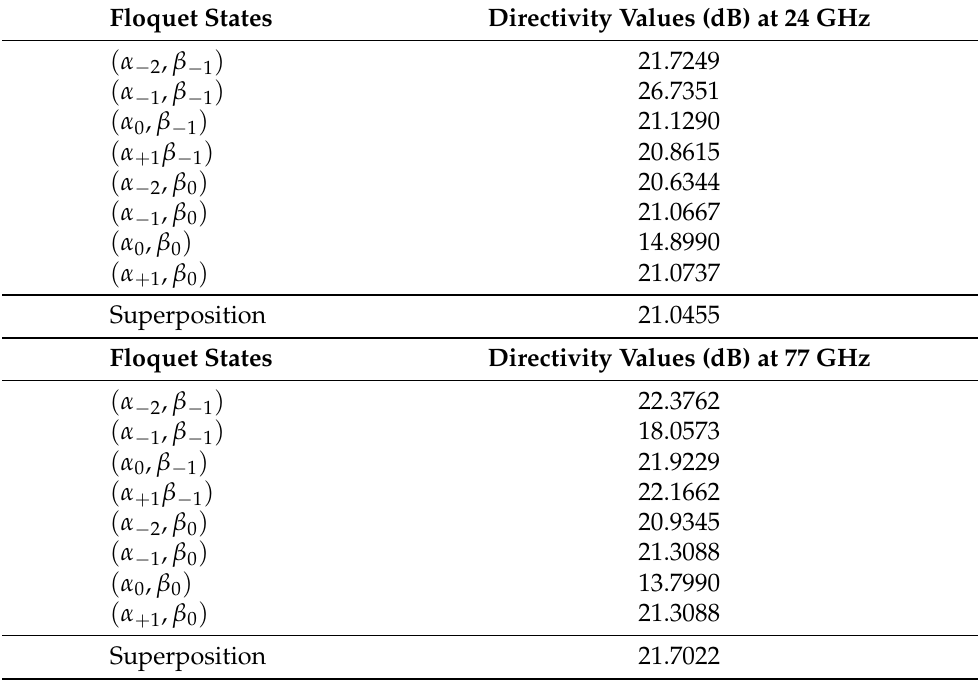
Table 2. Directivity versus Floquet states and the superposition theorem (or the modulation as explained in Formula (13), which transformed to study a finite array) for φ s = 0, θ s = 45 ◦ steering angles (FMCW radar